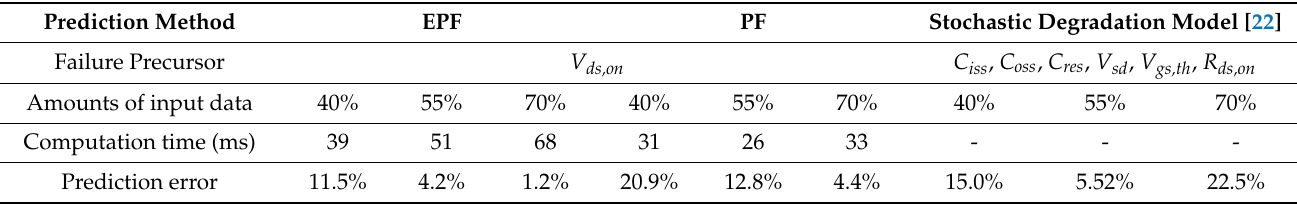
which makes it a promising candidate for RUL prediction. Table 4. Comparison of different kinds of RUL prediction